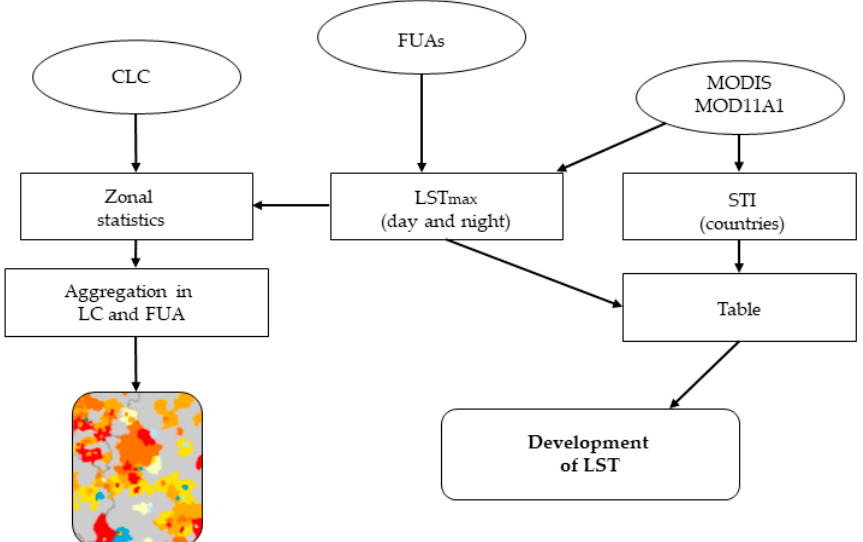
Figure 2. Methodology. With CLC as Corine Land Cover, LC as land cover, FUA as functional urban areas, LST as Land Surface LST, and STI as Standardized Temperature Index.